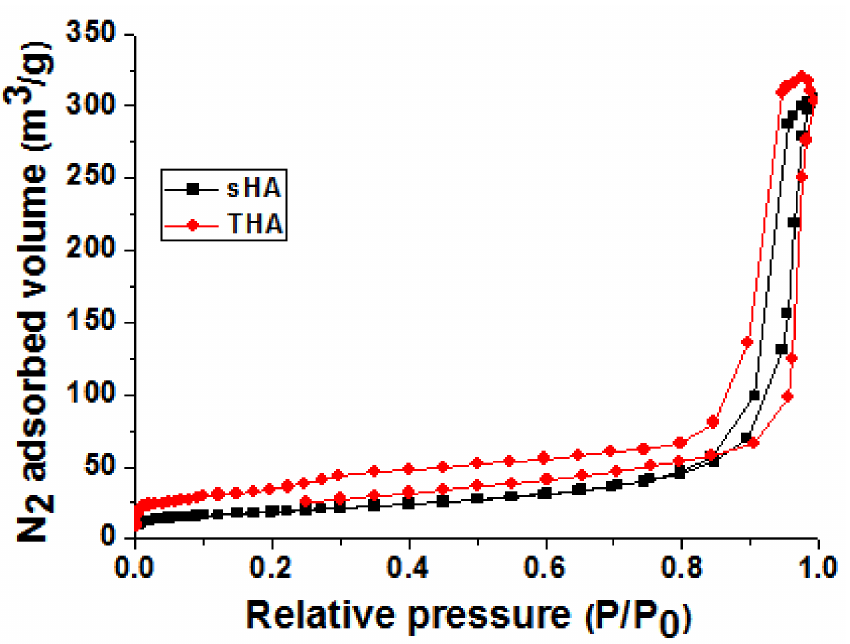
Figure 4. Nitrogen adsorption–desorption isotherms of sHA and